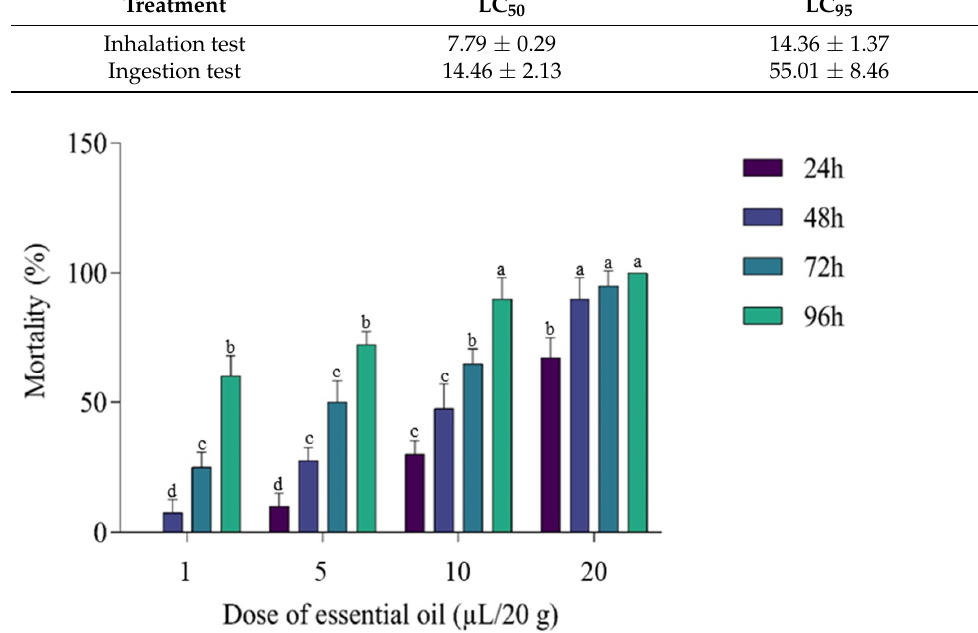
Figure 4. Mortality (%) of C. maculatus in the inhalation test caused by the exposure to the EO (µL/L of air). The test lasted four days, and the results were obtained at 24, 48, 72, and 96 h. All treatments had a significant effect compared with the control (0%). Column values with the same letters do not differ significantly ( p < 0.05) (Tukey’s HSD test). The results are expressed as mean ± SD. Table 6. Lethal concentrations of D. viscosa EO against C. maculatus. Results are expressed as mean ± SD. Treatment